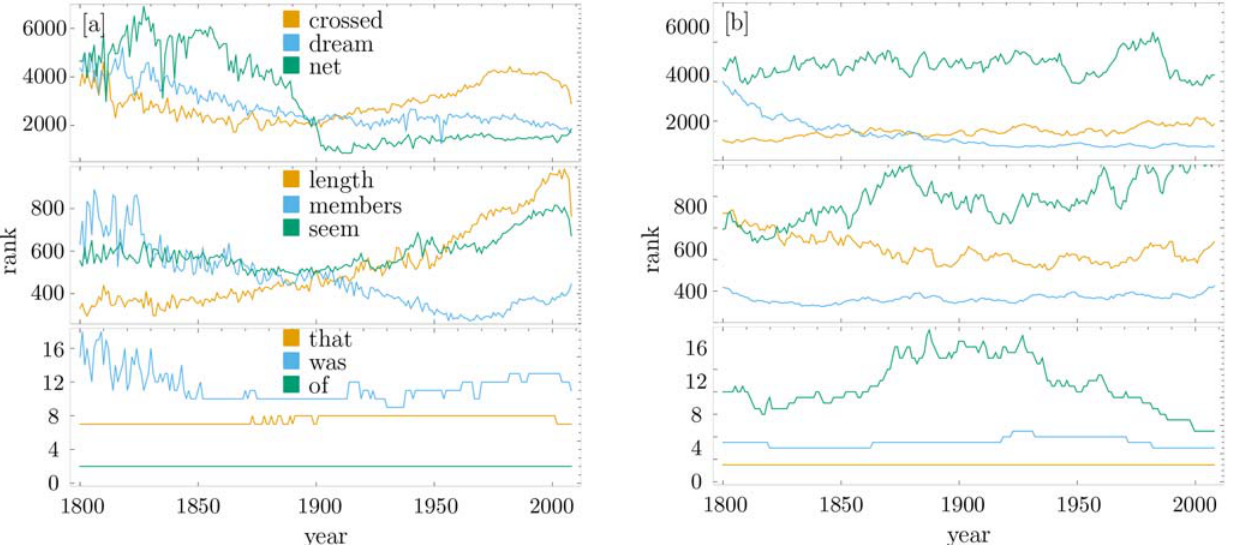
Fig 4. Rank evolution. [a]: Evolution of the rank for several particular, but random words in different regimes in the English language. From bottom to top we show words with initial ranks of order 1 (head), 100 (body) and 1000 (tail). [b]: Evolution of the rank for several particular, but random words in different regimes, for our scale-free Gaussian walker, i.e. the simulated language we have generated.